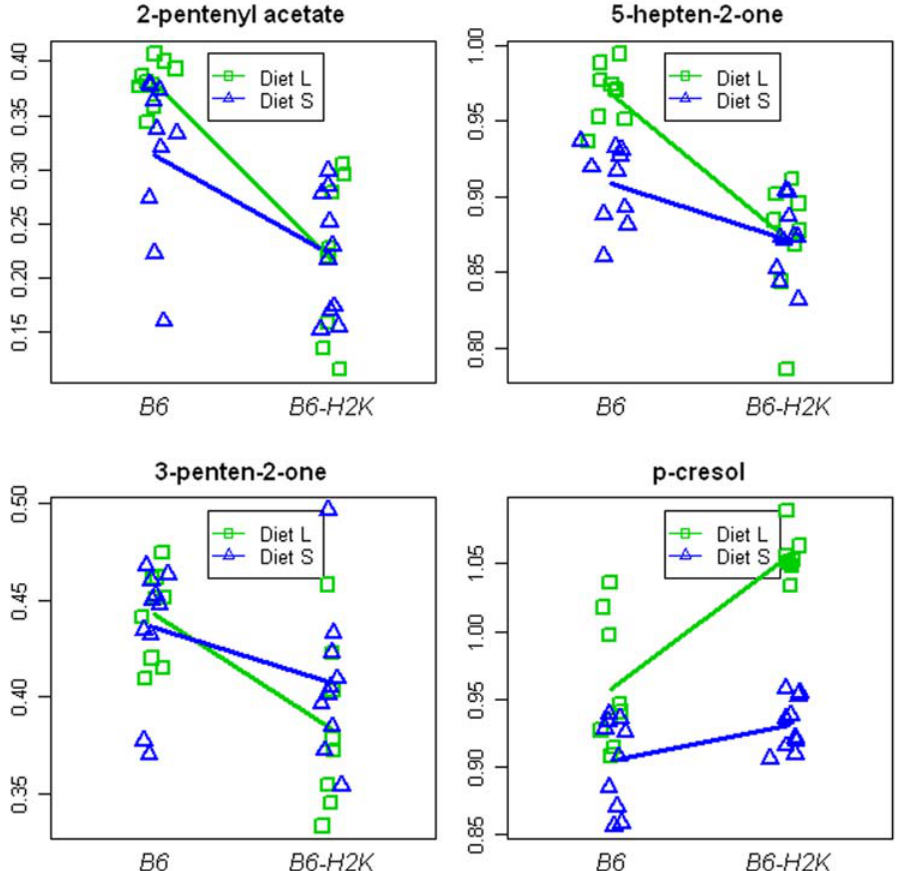
Figure 4. Distributions of the intensities for the top-ranked compounds affected by MHC types. Each panel displays normalized intensity values (y-axis) for a single metabolite affected by MHC types. MHC type is given on the x-axis, and different diets are distinguished by color and plotting character (green square for Diet L; blue triangle for Diet S). A line connecting average responses for each MHC type is shown separately for Diet L (green) and Diet S